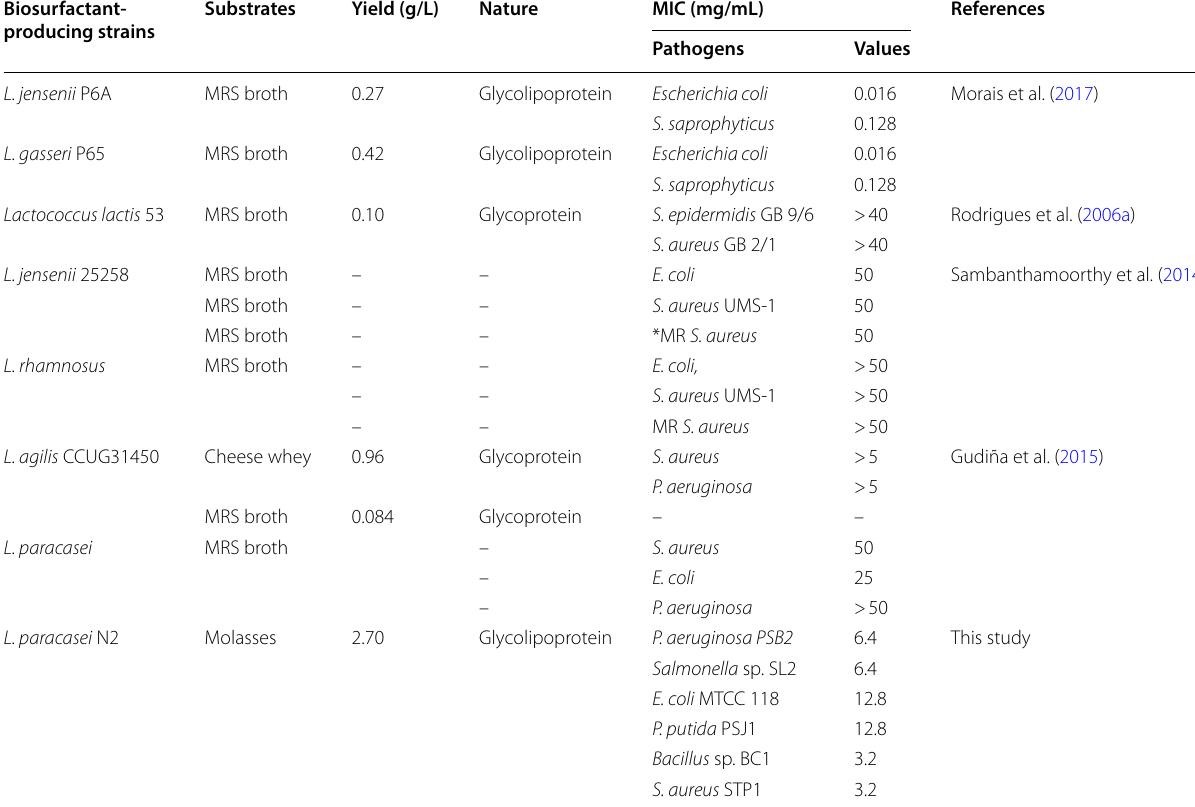
Table 7 Comparison of the properties of biosurfactants from this study with those reported in the literature